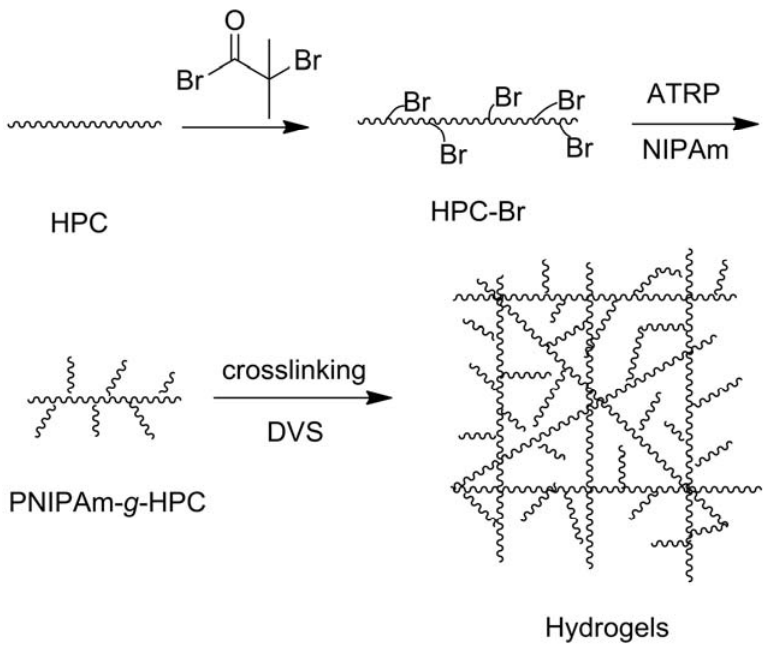
Figure 8. Schematic diagram illustrating the processes for the preparation of the PNIPAm- g -HPC copolymers via ATRP of NIPAm from the alkyl bromide-functionalized HPC macroinitiator and the formation of stimuli-responsive hydrogels via crosslinking. Reprinted with permission from [55]. Copyright 2010 American Chemical